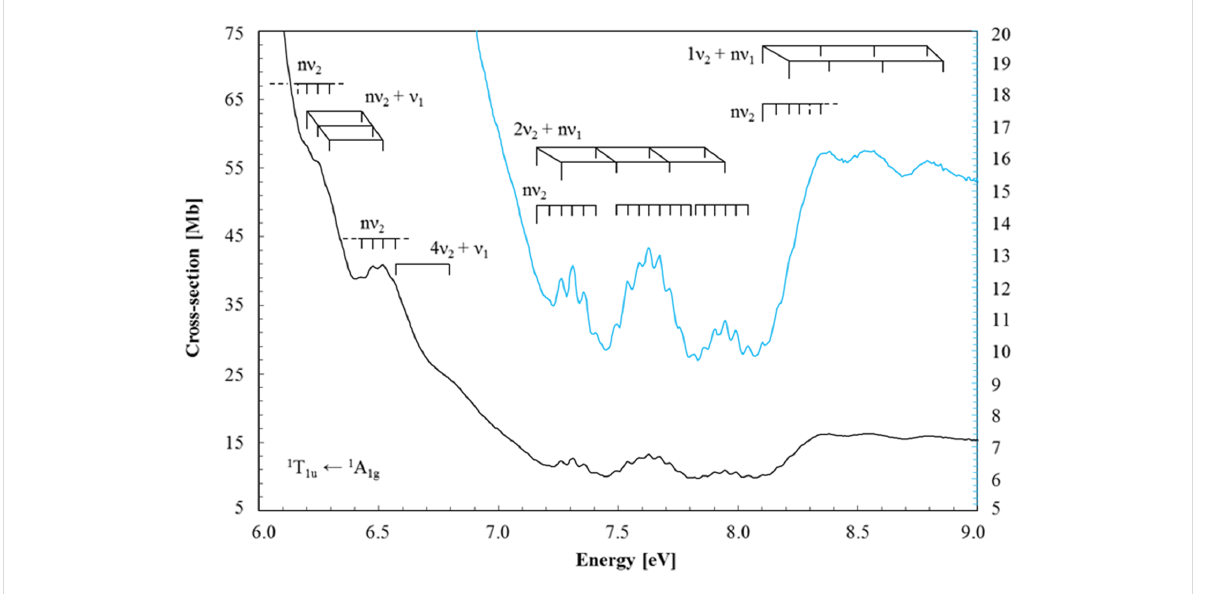
Figure 4: High-resolution VUV photoabsorption spectrum of W(CO) 6 in the photon energy range of 6.0–9.0 eV. See text for details on the assign- ments.